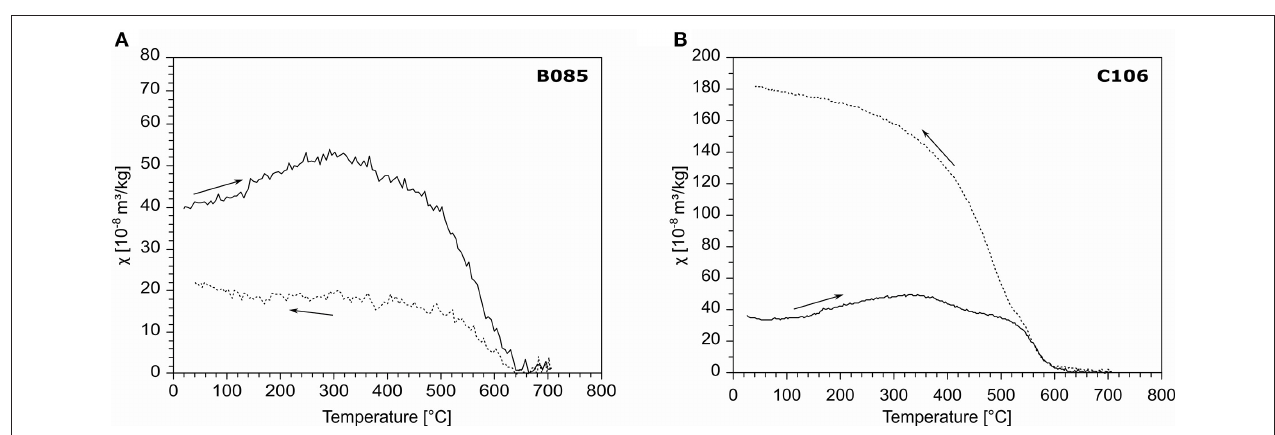
FIGURE 5 | Rock magnetic parameters measured along the section with median values indicated by dashed lines: (A) profile with simplified color chart and grain size indication on the right (cl, claystone; si, siltstone; fs, fine sandstone; ms, medium sandstone), (B) lithofacies (0–alluvial fan, 1–dry mudflat, 2- wet mudflat), (C-G) concentration-dependent parameters ( χ , SIRM, ARM, HIRM, NRM), (H) magnetic mineral indicator (s-ratio), (I-L) grain size dependent ratios (kfd, χ ARM / χ , SIRM/ χ , ARM/SIRM), (M) NRM/ARM as an indicator for natural remanence intensity to remanence capacity, (N) magnetic grains size (i.e. domain-state) indicative ratio M rs /M s , (O,P) parameters of degree and shape of anisotropy of magnetic susceptibility (P j , T). For explanation of abbreviations, see section Sampling and Methods.